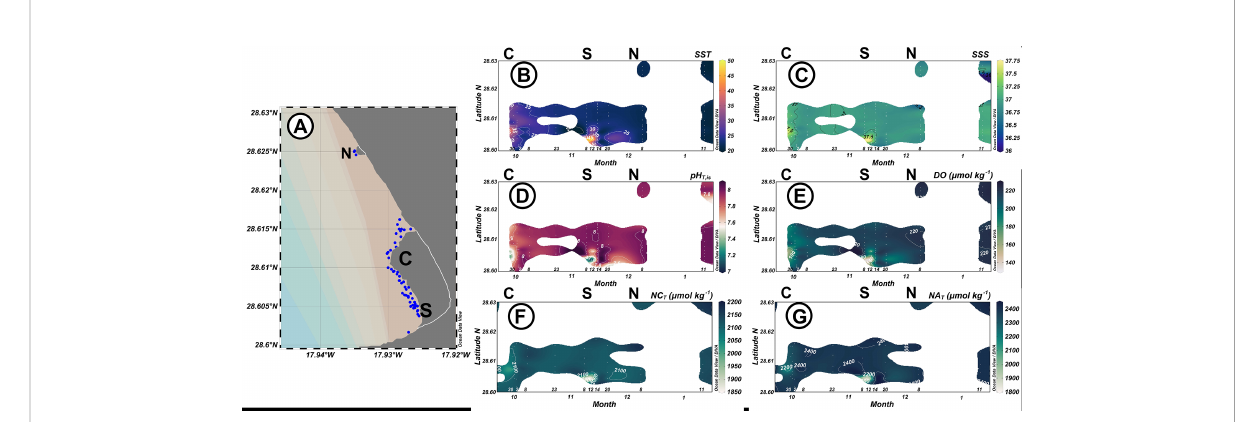
FIGURE 3 (A) Map of the coast of Tazacorte with the newly gained shoreline delimited with the white line. Blue dots correspond to the sampling stations. North (N), center (C), and south (S) correspond with the locations of the pre-lava arrival stations. Surface seawater properties of (B) temperature (SST in °C), (C) salinity (SSS), (D) pH in total scale at in-situ conditions (pH T,is ), (E) dissolved oxygen concentration (DO, µmol kg − 1 ), (F) normalized to a constant salinity of 37 C T (NC T , µmol kg − 1 ), and (G) normalized to a constant salinity of 37 A T , (NA T , µmol kg − 1 ) from 22nd September 2021 to 11th January 2022 at a distance of 15 – 25 m from the two formed deltas at the coast of Tazacorte, La Palma. C, S, and N correspond to the arrival of lava to the respective originally sampled stations at those